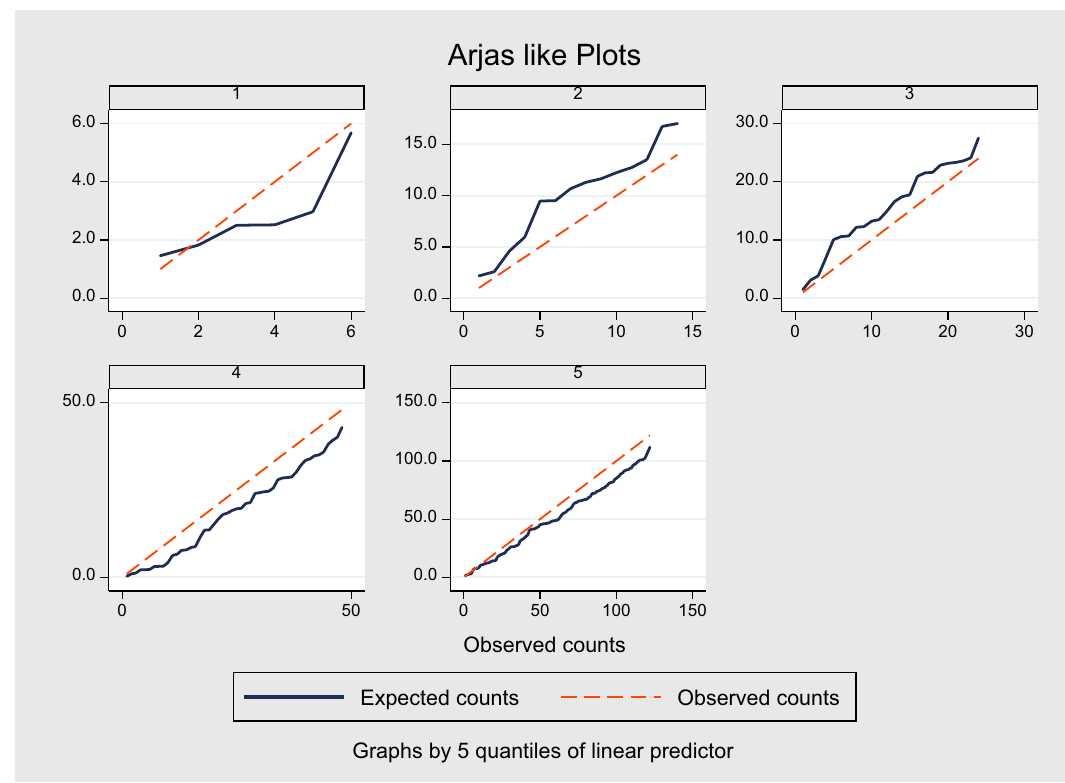
Figure 2. Arjas like plots to compare observed and expected events in five quantiles of the linear predictor in the validation sample.